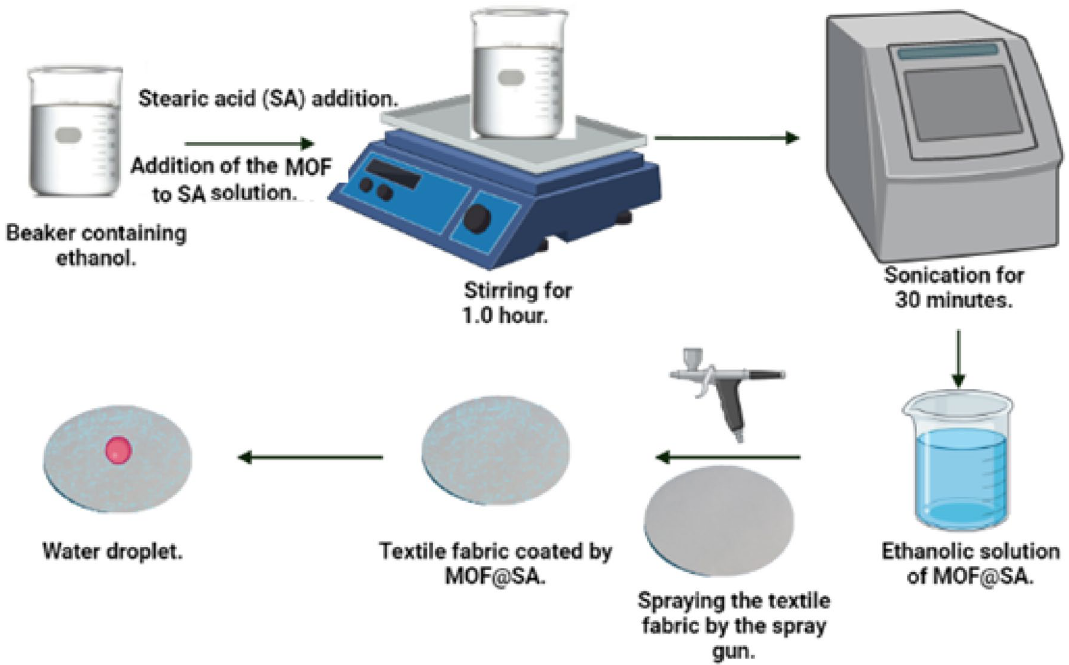
Figure 1. Schematic diagram of the manufacturing of superhydrophobic textile fabric, TF@Cu-Asp